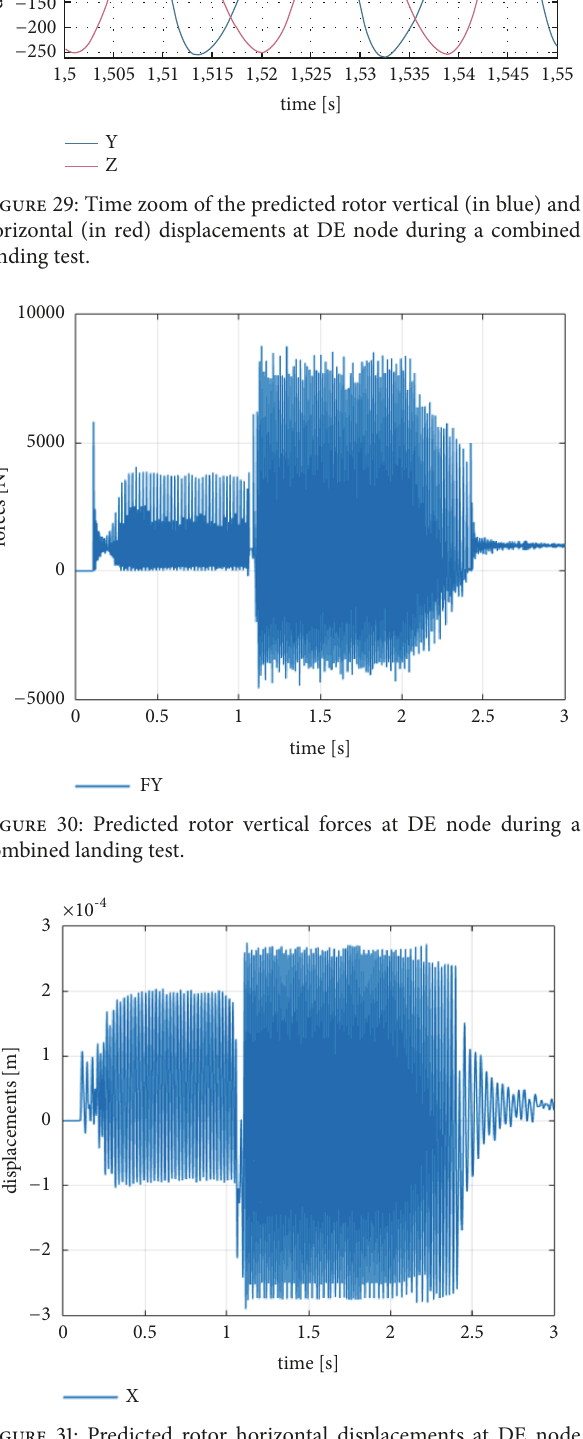
Figure 31: Predicted rotor horizontal displacements at DE node during a combined landing test.